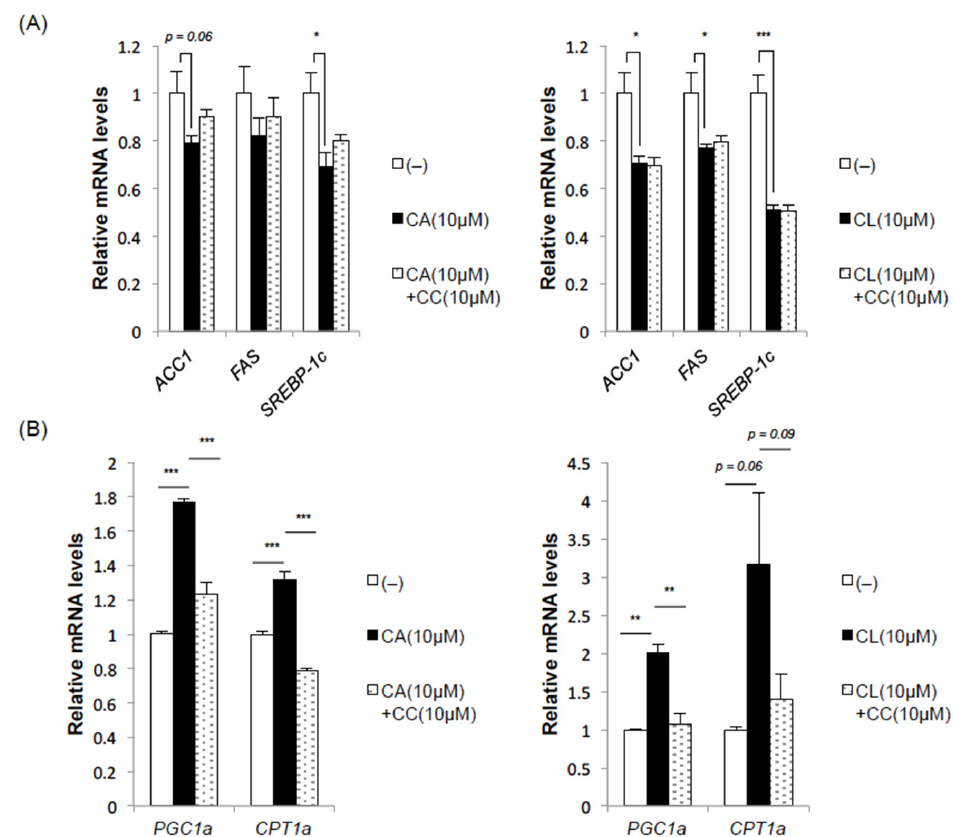
Figure 3. CA and CL suppress lipogenic gene expressions while upregulating genes related to fatty acid oxidation in HepG2 cells. HepG2 cells were pretreated with compound C (CC) (10 µ M) for 1 h and then stimulated with CA (10 µ M) or CL (10 µ M) for 24 h. ( A ) Lipogenic gene expressions. ( B ) Expressions of genes related to fatty acid oxidation (*: p < 0.05, **: p < 0.01. ***: p < 0.001).